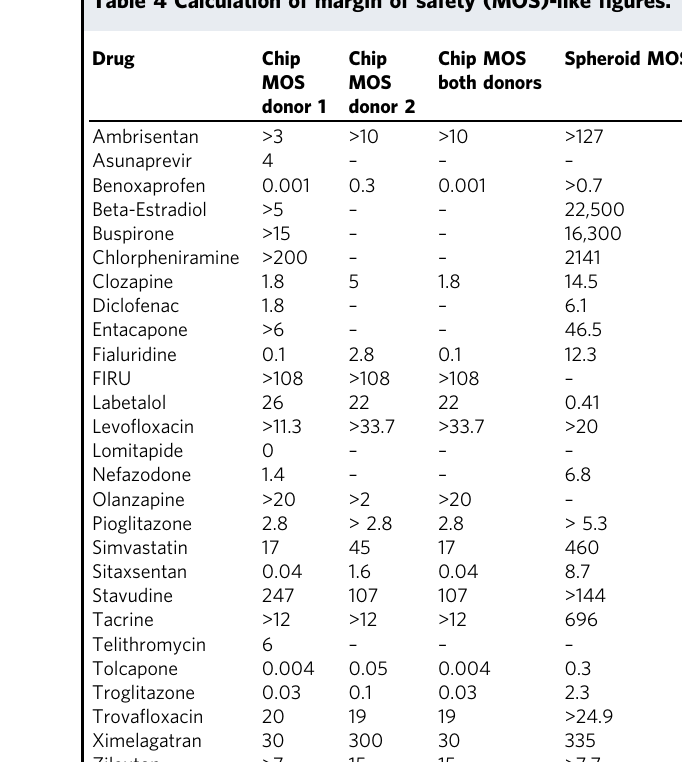
Table 4 Calculation of margin of safety (MOS)-like fi